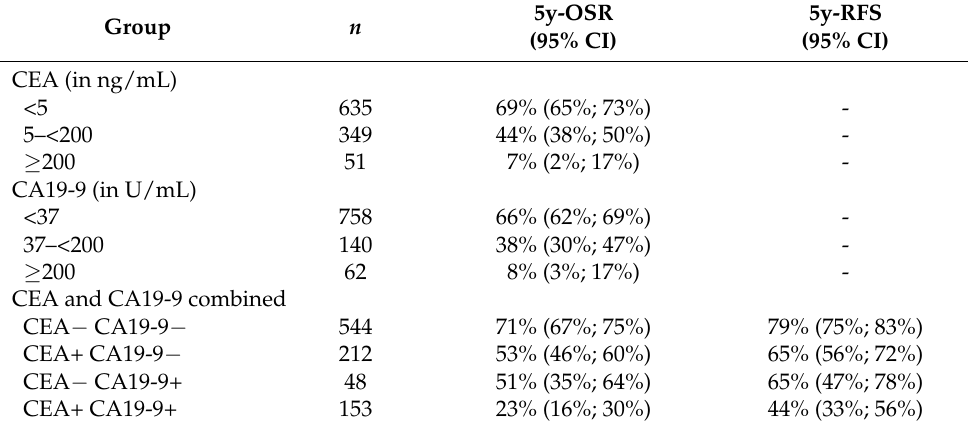
Figure 3. ( a ) Kaplan–Meier curves showing overall survival for patients with a preoperative CEA level below the cut-off value (turquois), with an increased CEA value between 5 and <200 ng/mL (blue), and with a CEA value ≥ 200 ng/mL (green). ( b ) Kaplan–Meier curves showing overall survival for patients with a preoperative CA19-9 level below the cut-off value (turquois), with an increased CA19-9 value between 37 and 200 U/mL (blue), and with a CA19-9 value ≥ 200 U/mL (green). Table 2. Impact of CEA and CA19-9 on